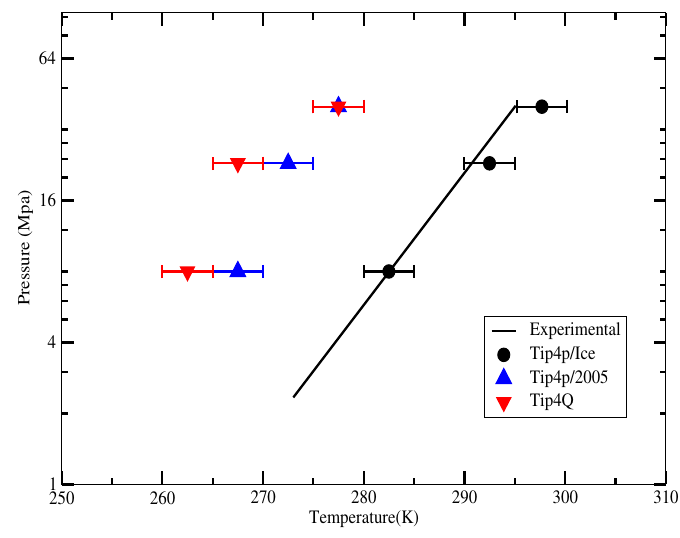
Figure 10. Three-phase coexistence temperature at different pressures with different water models, experimental results were taken from [1].